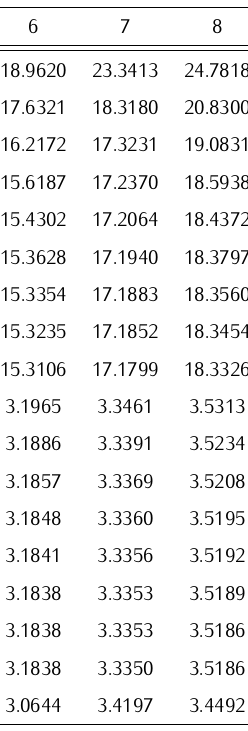
with edges elastically 9